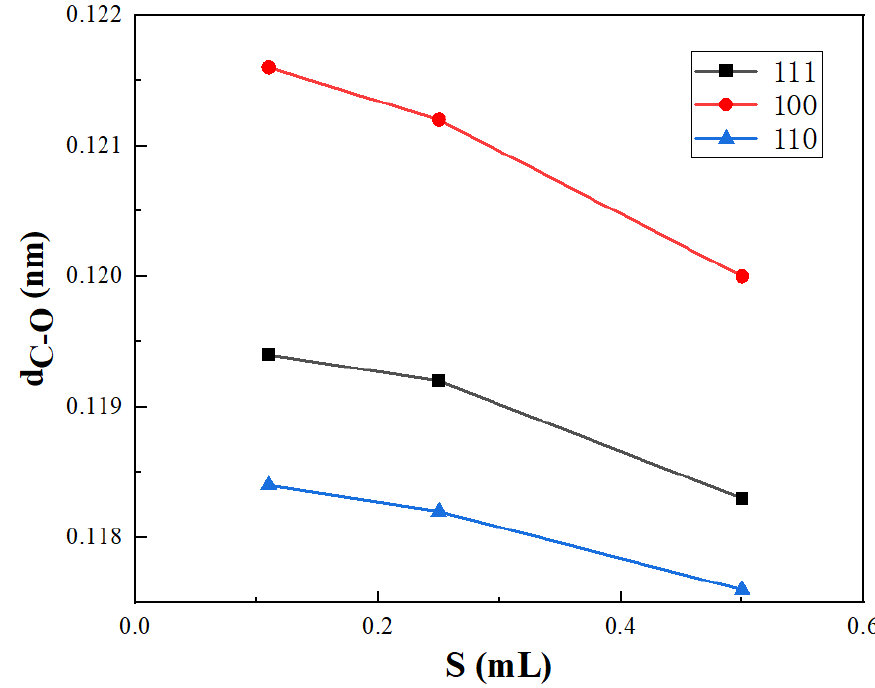
Figure 6. The variation of C-O bond lengths with coverage on three crystal surfaces.